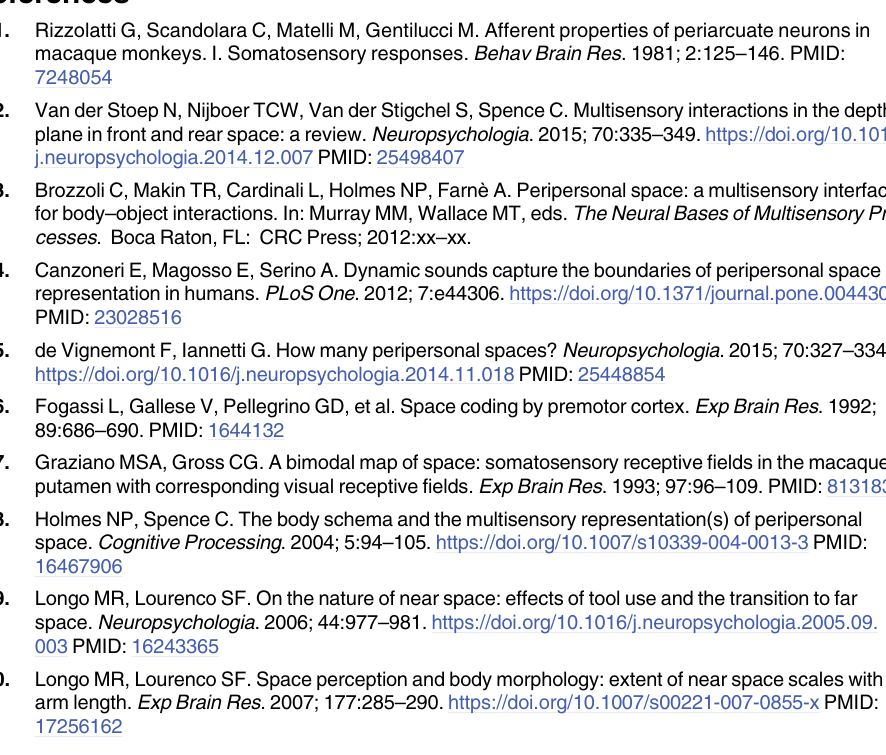
S1 Table. Dataset.xls. Timed ERSP data are reported for each frequency